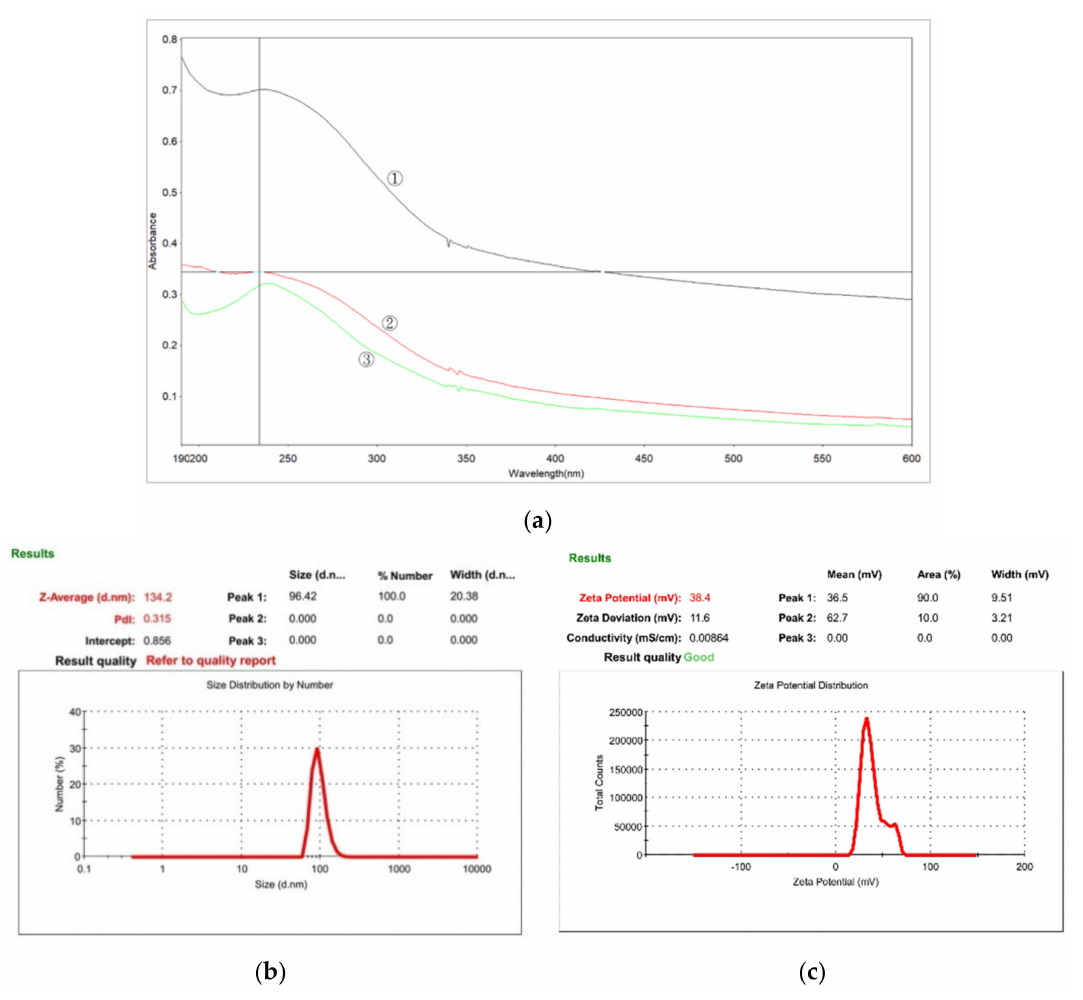
Figure 11. Absorption peak curves of a nano-bicolloidal solution prepared by micro-EDM. ( a ) Absorption peak curves ( b ) size (duty cycle is 50–300 us) and ( c ) zeta potential (duty cycle is 50–300 us). Table2.